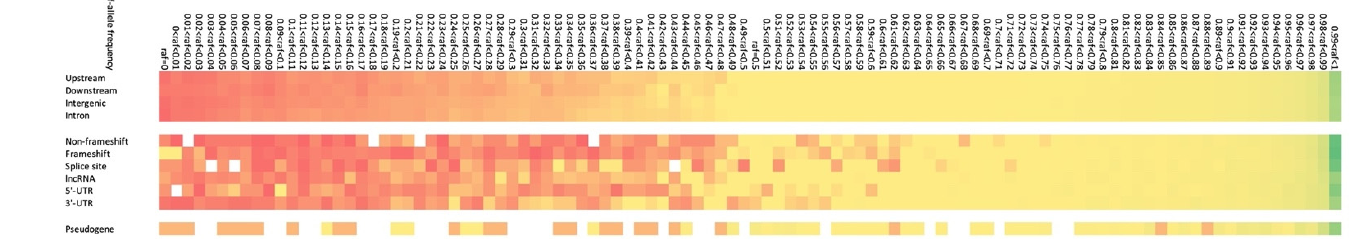
Figure 5. Distribution density of insertions and deletions (INDELs) in genomic functional regions. The distribution density (0.640%: yellow) of frameshift INDELs was higher than that of non-frameshift INDELs (0.160%: red) in the 0% Ref allele frequency (left side of Figure 5). Vertical line: upstream, downstream, intergenic, intron, non-frameshift, frameshift, splice site, long non-coding RNA, 5 ′ -UTR, and 3 ′ -UTR. Horizontal line: reference allele frequency, left side: low frequency, right side: high frequency. Red, yellow, and green show low, middle, and high densities, respectively.